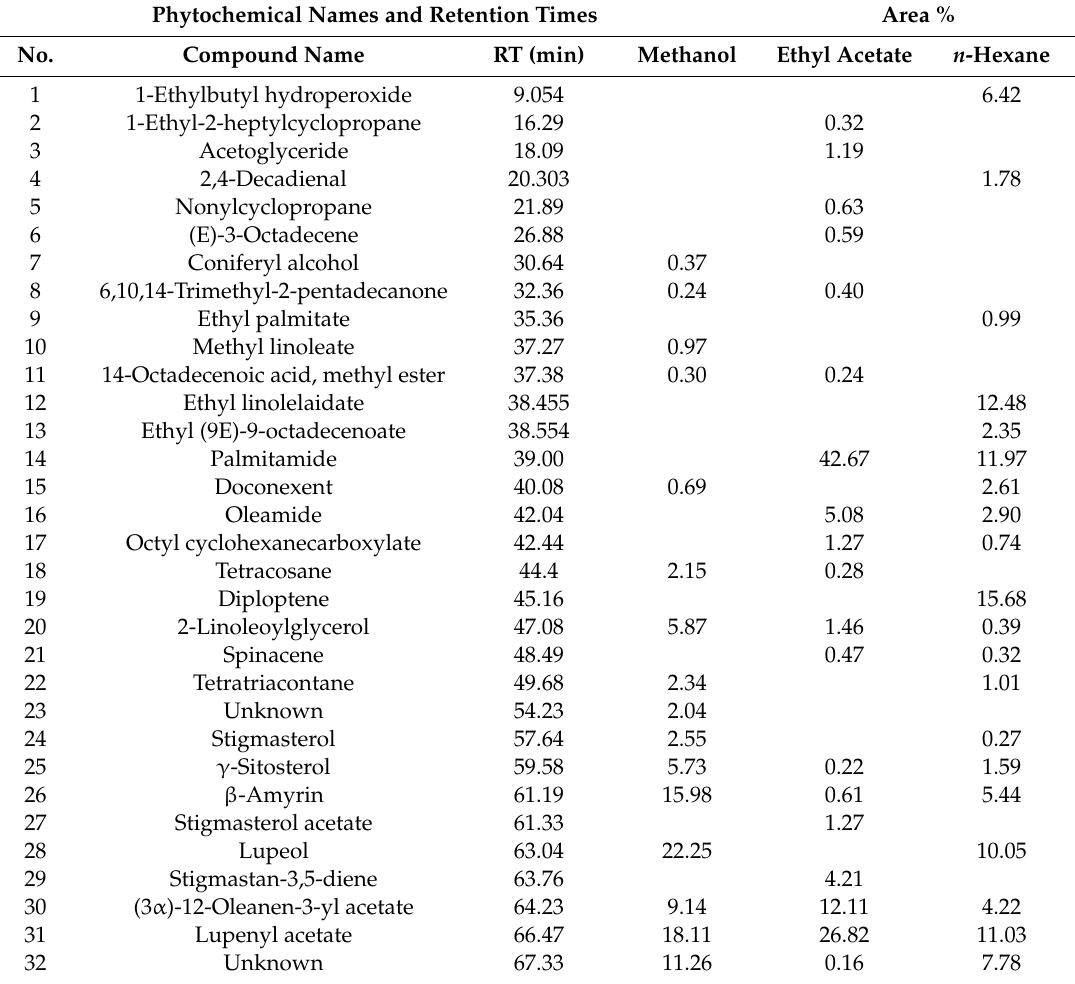
Table 1. Phytochemical percentages and retention times for wild S. maculatus extracts of methanol, ethyl acetate, and n -hexane, identified by gas chromatography-mass spectrometry (GC-MS). Phytochemical Names and Retention Times Area